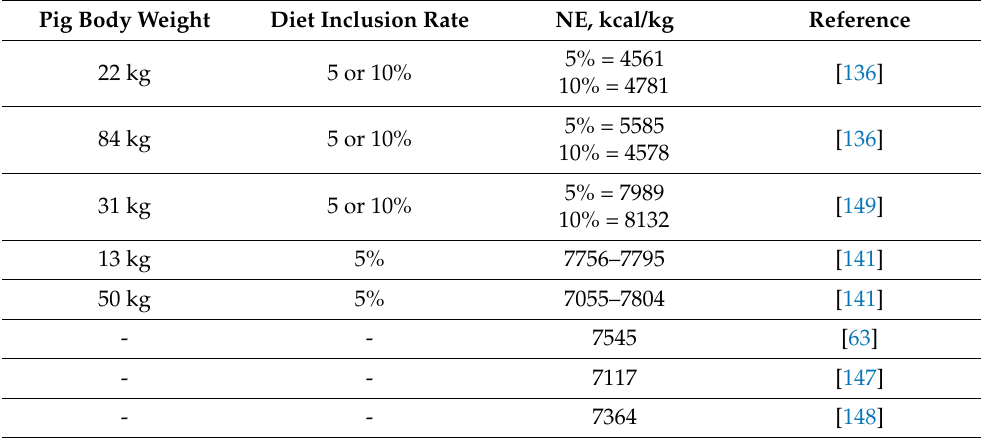
Table 7. Summary of estimates of net energy (NE) content of soybean oil in swine